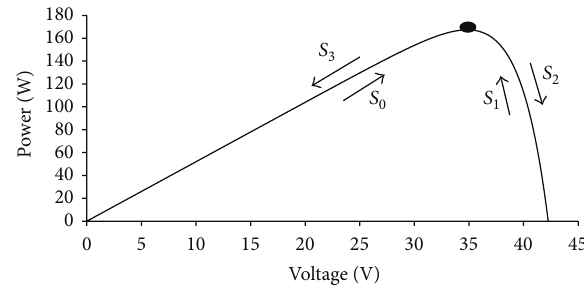
Figure 4: Four states of the